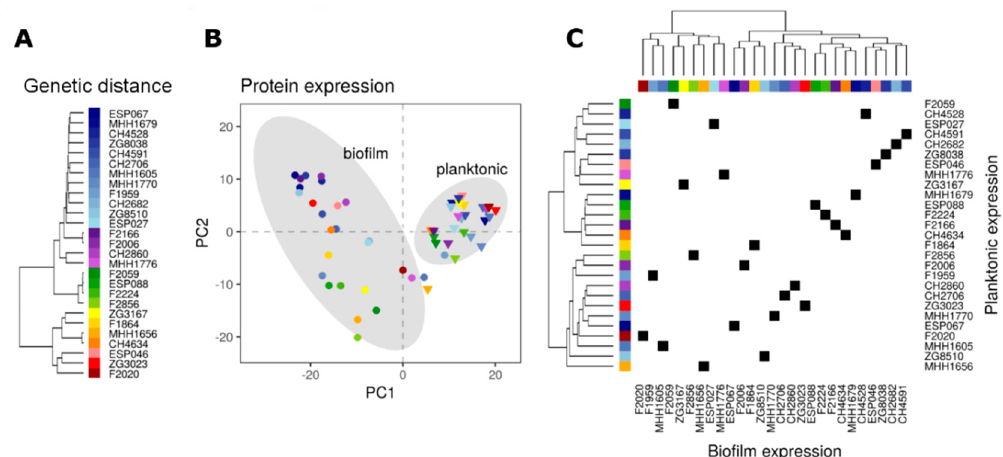
Figure 1. Protein expression profiles of biofilm and planktonically grown clinical P. aeruginosa isolates of diverse genetic background. ( A ) Hierarchical clustering by genetic distance based on the 1021 genes for which the encoded proteins were quantified in this study. PAO1-like strains predominate and are colored in blue-, violet-, and green colors, respectively. PA14-like strains are colored in yellow/orange or red. ( B ) Principal component analysis (PCA) of the isolates based on the acquired proteomic data. Biofilm (circles) and planktonic (triangles) proteomes of the clinical isolates (same color code as in A) are clearly separated. The grey areas represent the 95% confidence ellipse of the biofilm and planktonic proteomes, respectively. ( C ) Correlation matrix comparing the biofilm and the planktonic proteomic profiles of the clinical isolates. Each square reflects the position of an individual isolate on the two axes. The horizontal dimension represents the hierarchical clustering of protein expression data based on normalized expression of the 1021 proteins in the data set of clinical isolates grown under biofilm conditions, while the vertical dimension corresponds to hierarchical clustering of planktonic protein expression data. The phylogenetic strain background is indicated by colored subtrees (color code as in A) within the dendrogram.